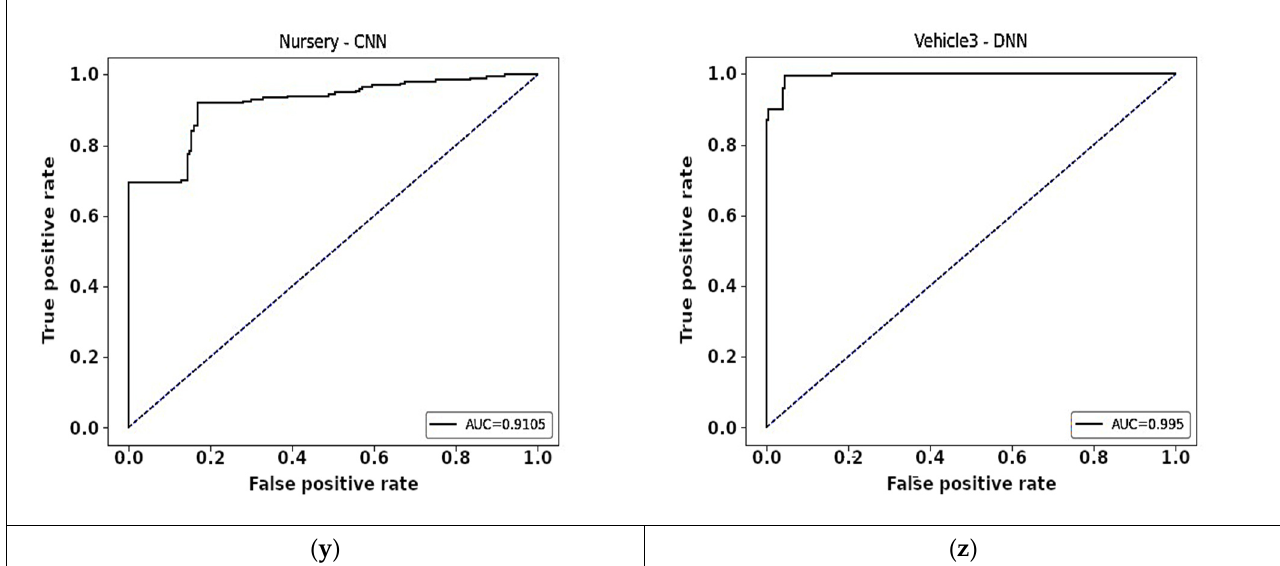
Figure 12. ROC plots for the models from ( a – z ).